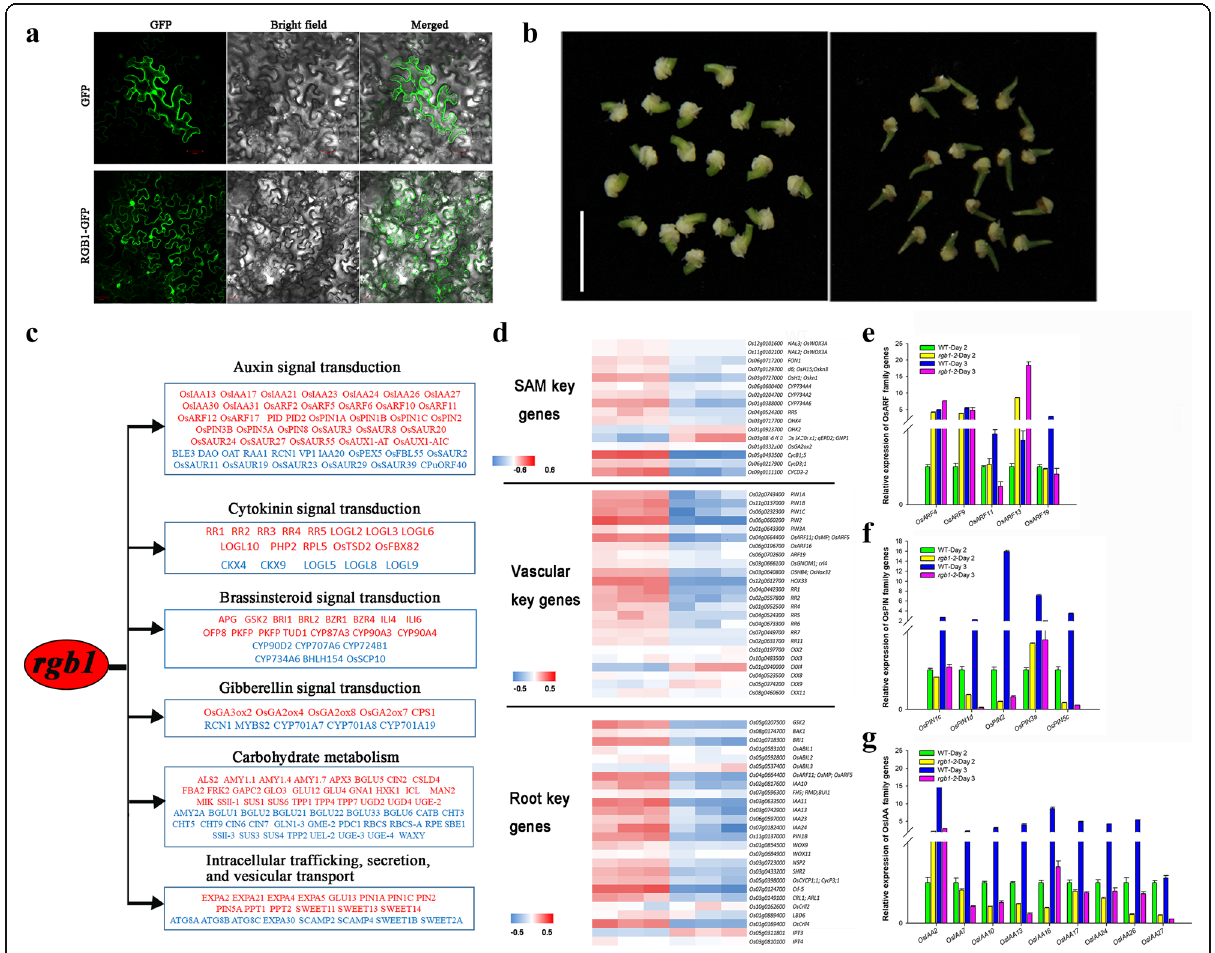
Fig. 6 Transcriptomic analysis of young rice seedlings from wild type and rgb1 mutants. a Subcellular localization of RGB1. The localization of GFP alone and RGB1-GFP in N. benthamiana epidermal cells are shown. The images were obtained under an optical field to examine cell morphology (bright field), under a dark field to localize green fluorescent protein (GFP), and in combination (merged). M, membrane; N, nucleus. Bars = 50 μ m. b Tissues of WT and the rgb1 – 2 mutant used for RNA-seq and qRT-PCR. c Representative genes with known functions (Additional file 11: Table S6, genes with demonstrated functions) in various response/regulatory pathways. The genes whose expression is downregulated or upregulated in the rgb1 – 2 mutant and WT are shown in red and blue, respectively. d Hierarchical clustering displays of genes specifically expressed in the SAM, vascular tissue, and roots of the rgb1 – 2 mutants compared with the WT control. The blue color indicates upregulation, and the red color indicates downregulation in the embryo; the white color indicates that the expression intensity was not detected. e-g Transcript levels of auxin signal transduction-related genes at 2 and 3 days after germination. e OsARF family genes. f OsPIN family genes. g OsIAA family